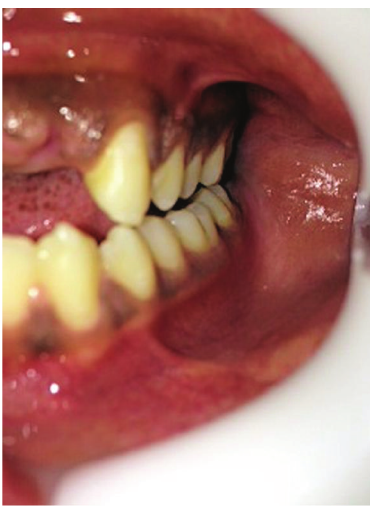
Figure 5: Provisional fixed partial denture in patient mouth.